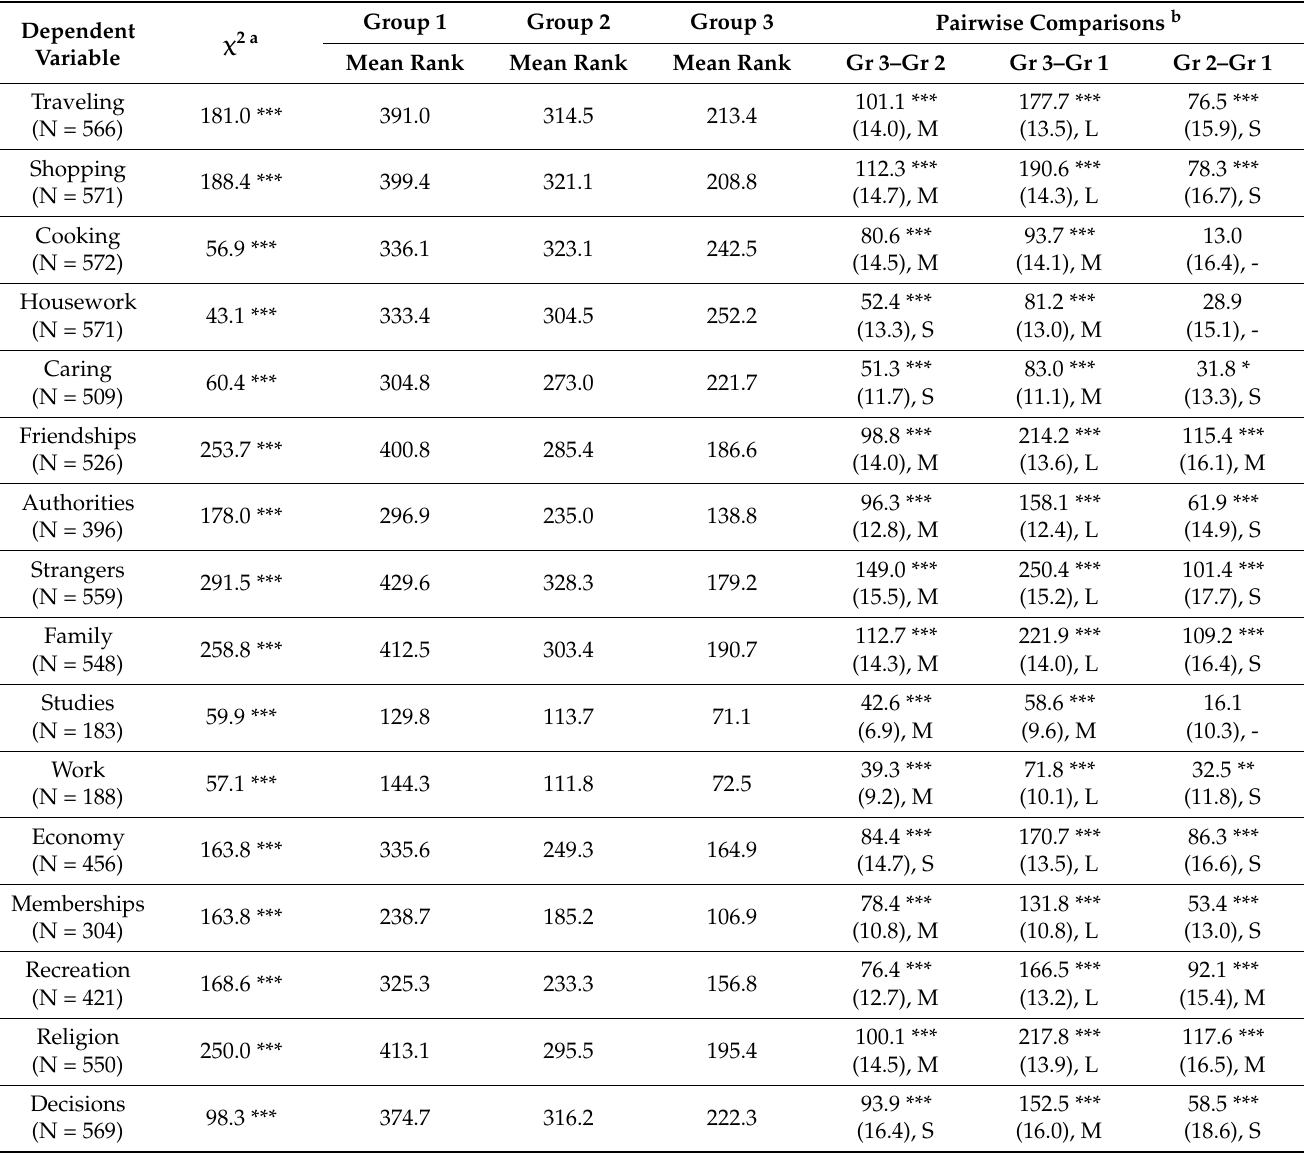
Table 3. Kruskal–Wallis test with significance values adjusted by the Bonferroni correction for multiple tests for the data set on